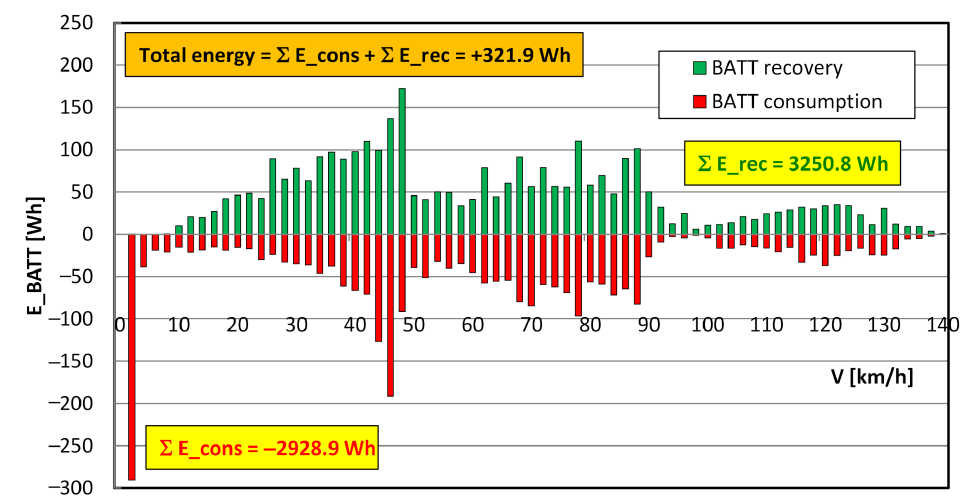
Figure 9. Shares of battery energy use during discharge and charge in relation to driving speed.